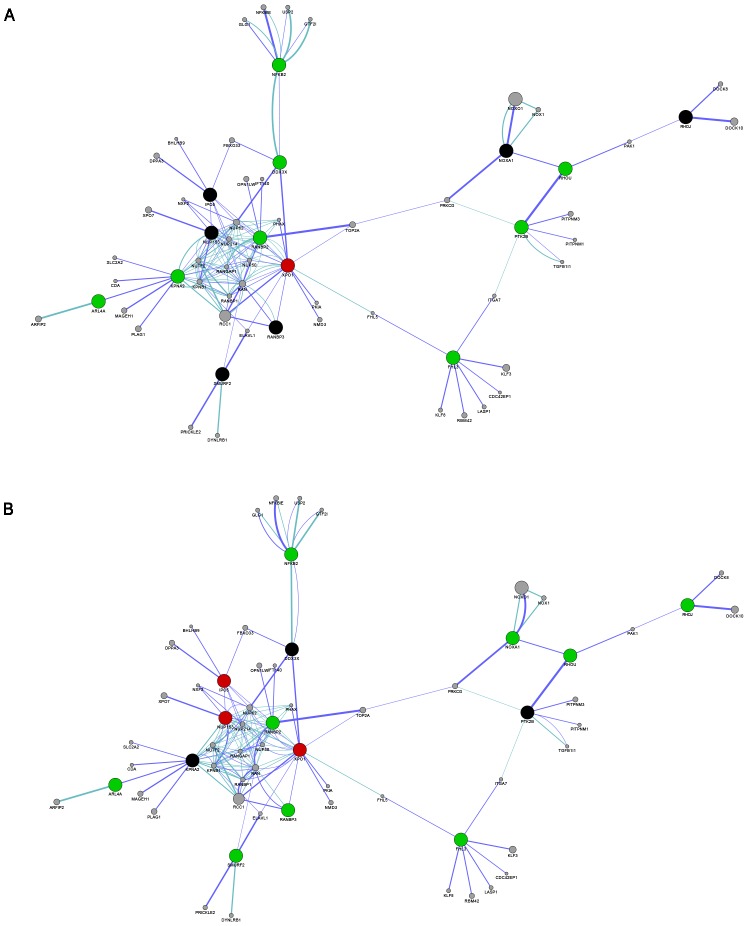
Functional network for ICM (A) and DCM (B).Analysis was based on protein-protein interaction (dark blue lines) and pathway (light blue lines) databases with the nucleocytoplasmic transport-related genes (>1.29-fold; P<0.05). GeneMANIA retrieved known and predicted interactions between these genes and added extra genes (small grey circles) that are strongly connected to query genes (large circles). Red indicates upregulation, green indicates downregulation and black indicates no differences in the trend expression between the two comparisons (ICM vs. CNT and DCM vs. CNT).